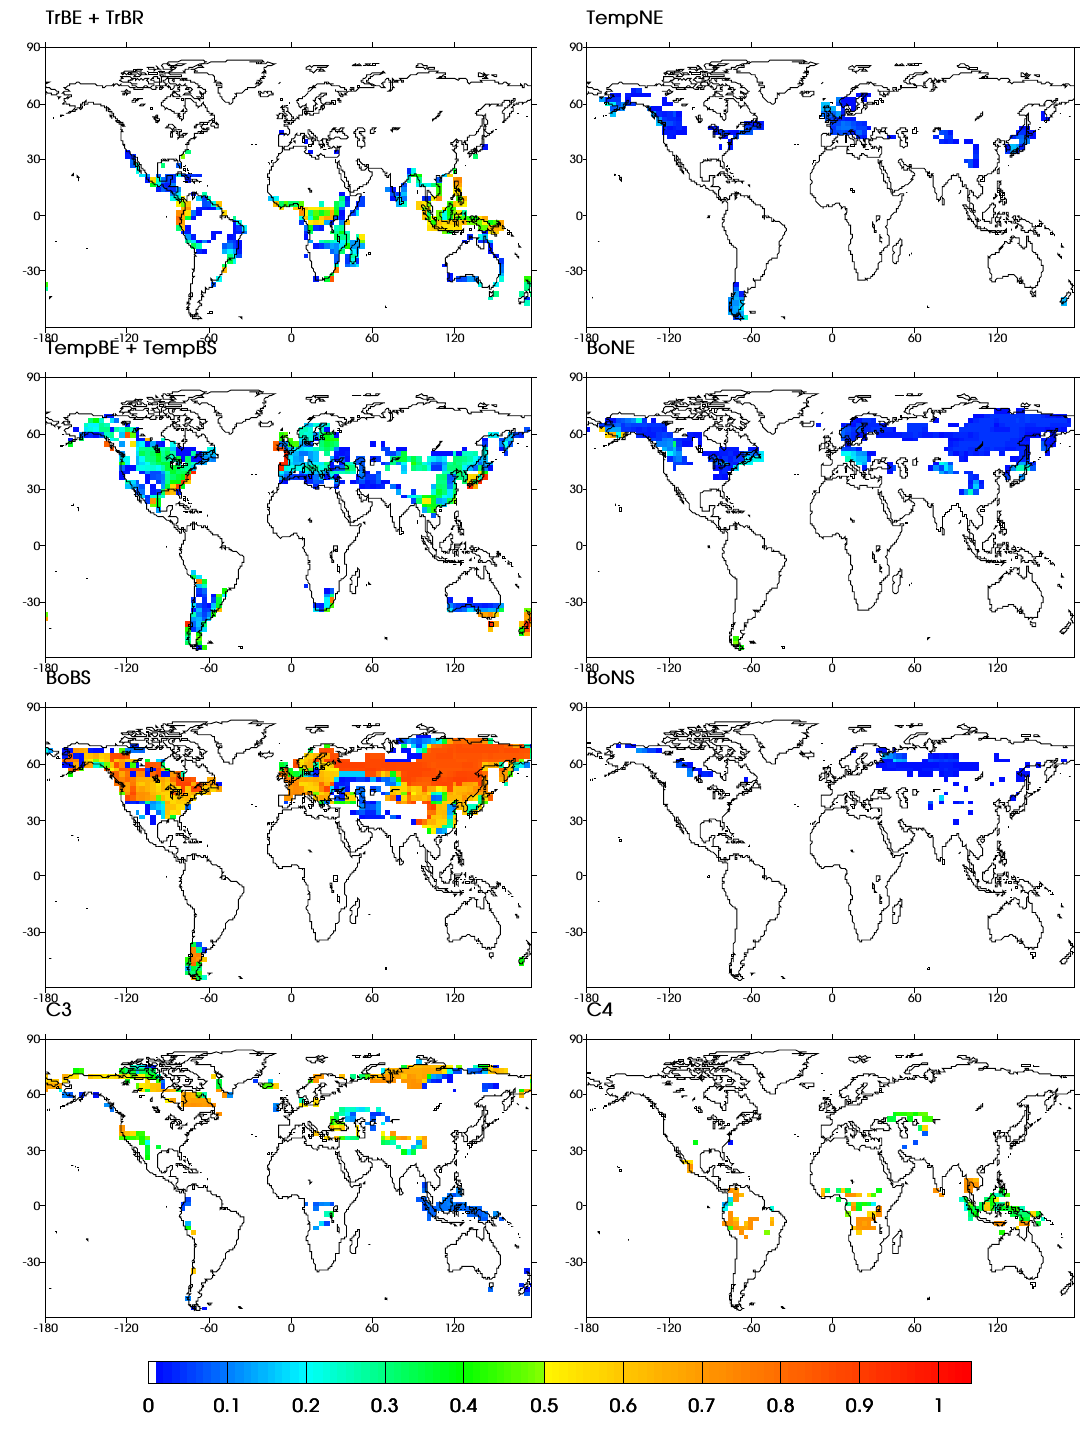
Fig. 12. Fraction of vegetation (annual maximum, in % of grid-cell) simulated by ORCHIDEE in CTRLG (present-day climate and glacial CO 2 for photosynthesis). Abbreviations: see Table